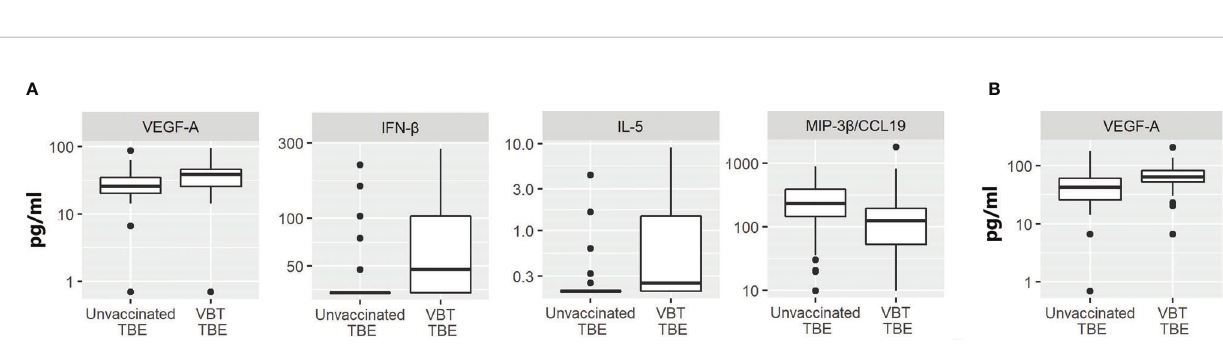
FIGURE 3 | The concentrations of immune mediators that signi fi cantly differed in (A) CSF or (B) serum samples between VBT TBE patients (VBT TBE; n=41) and in age and gender matched unvaccinated TBE patients (Unvaccinated TBE; n=81) obtained at the onset of neurological